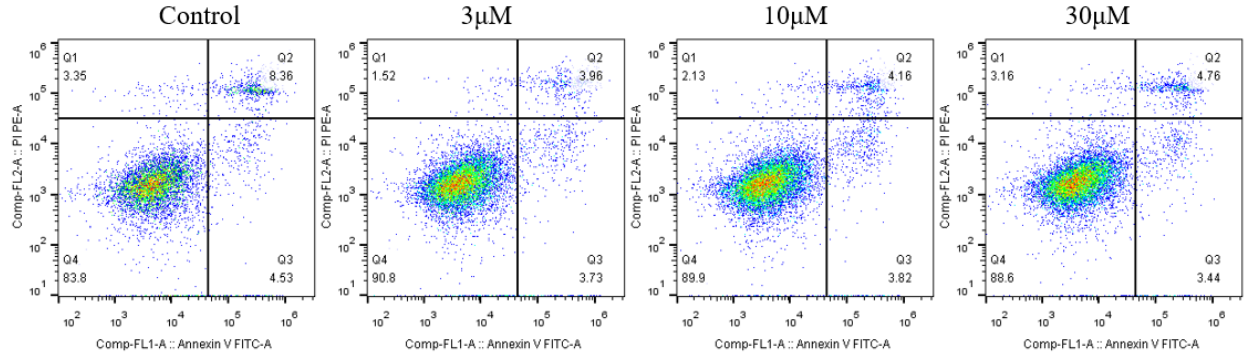
Figure 3. OPCs were treated with stemazole for 4 days, and apoptosis was analyzed by flow cytometry after staining with annexin V and propidium iodide. Values shown are the percentage of cells stained with annexin V.